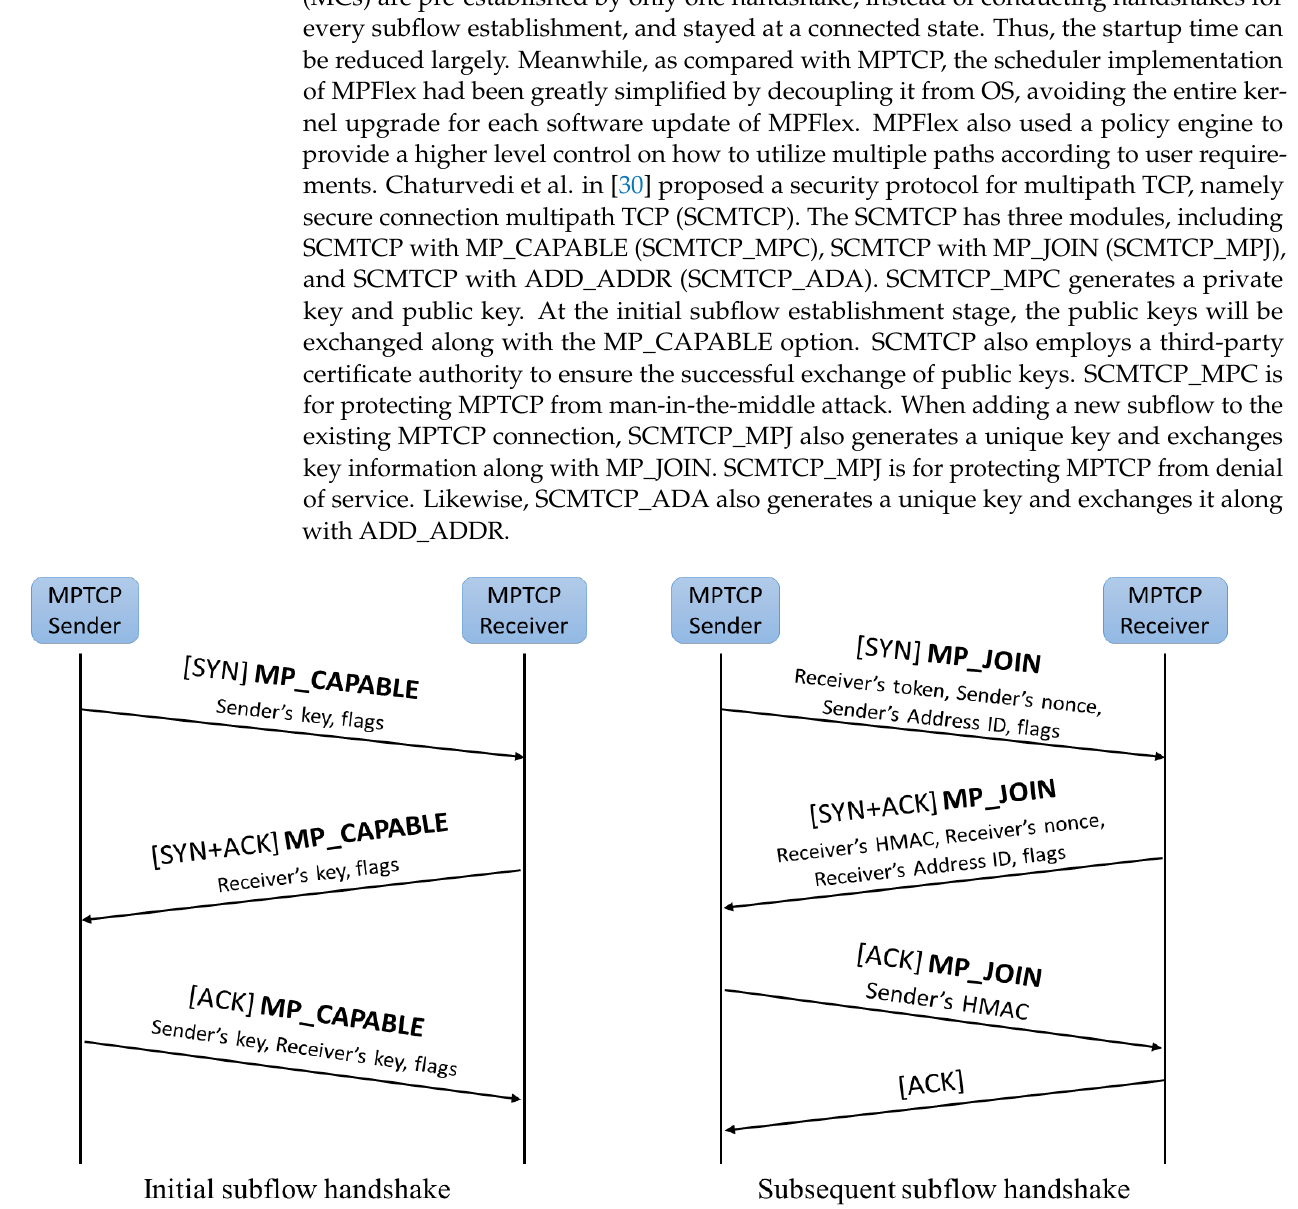
Figure 2. Multipath TCP initial subflow handshake and subsequent subflow